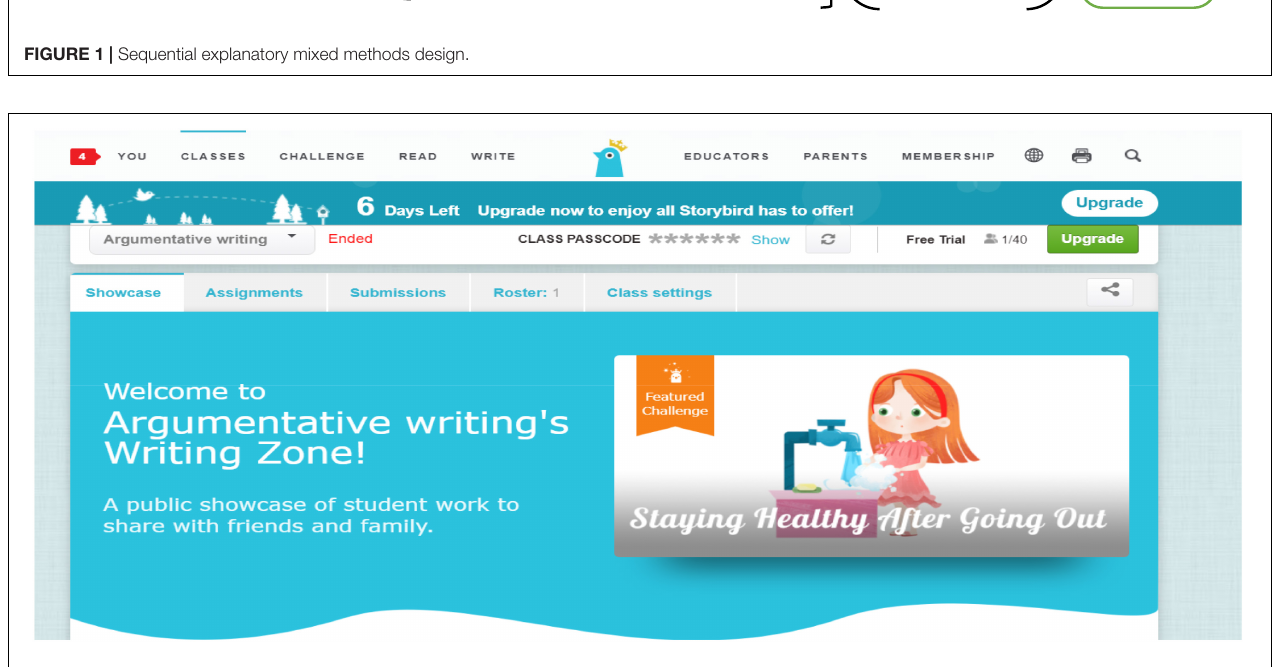
FIGURE 2 | Screenshot of the Storybird website used for Group A students.